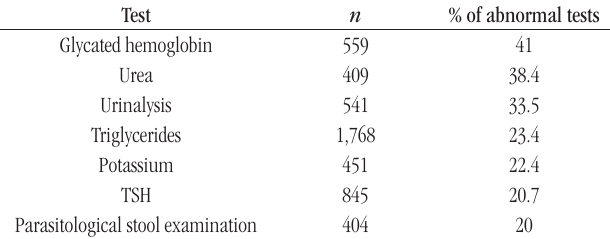
taBLE – Proportion of altered exams in the group of